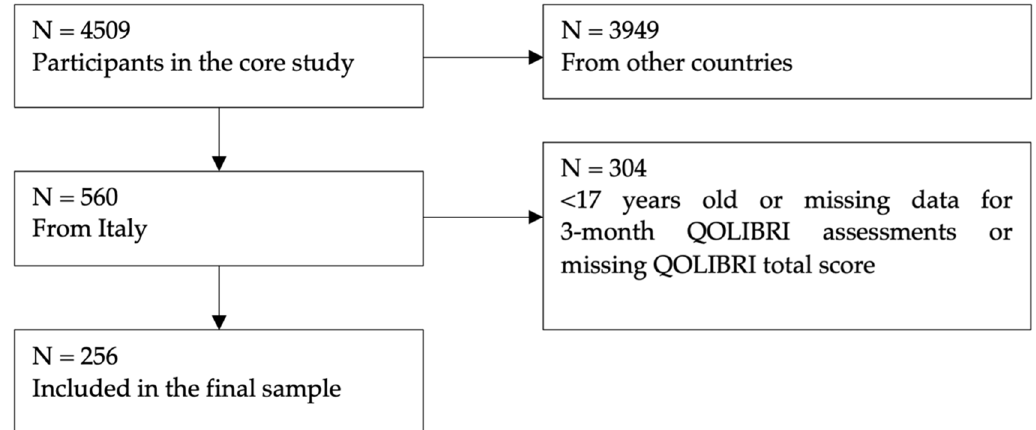
Figure 2. TBI sample attrition chart.